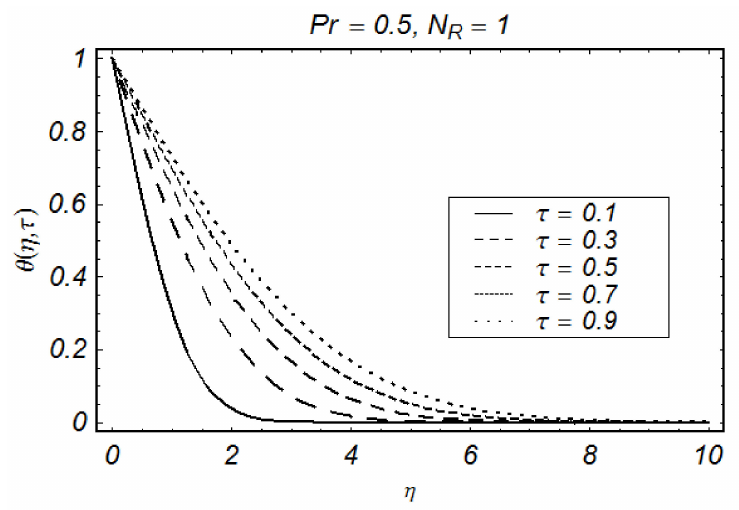
Figure 10. Indication of τ on temperature